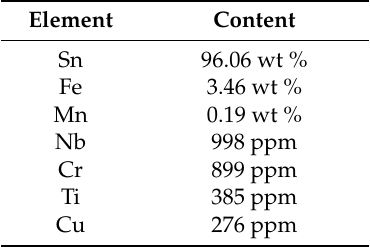
Table 4. Chemical composition of tin metal obtained by the pyrometallurgical reduction smelting process. Element